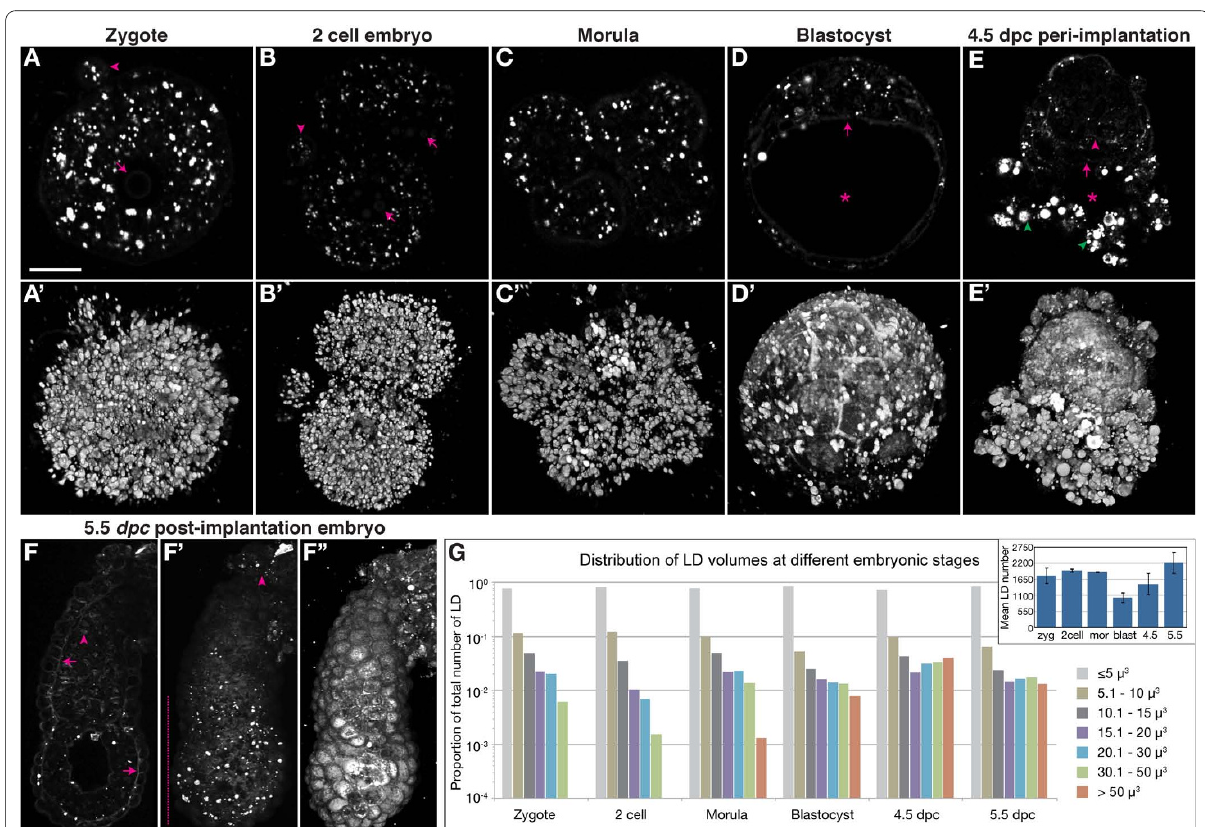
Figure 3 THG signal changes in a stage and region specific manner . (A - F) Optical sections. (A' - E' and F'') Opacity rendered 3D views. (F') Extend- ed focus maximum intensity projection. (A - C) Up to the morula stage, THG signal is predominantly from LD which are uniformly distributed through- out the embryo and polar body (arrowheads in A and B). Nucleoli also generate faint THG signal (arrows in A and B). (D) In blastocysts, LD are fewer in number and present in both the ICM (arrow) and TE. Plasma membrane starts to generate more distinct THG signal, visible more clearly in the volume rendering in D'. (E) In the implantation stage embryo, LD are mostly localised to the mural TE (green arrowheads). Plasma membrane is faintly visible and the primitive endoderm (magenta arrow) can be discerned from the epiblast (magenta arrowhead). The blastocoel cavity is marked by an asterisk in (D) and (E). (F) At post-implantation stages, LD are more abundant in the ectoplacental cone (arrowhead in F') and in the distal regions of the egg cylinder (vertical line in F'). Plasma membrane signal becomes more distinct, but is not uniform throughout the embryo, being strongest in the baso- lateral aspect of the VE (arrows). Nuclei are also now visible, but only in the ExE (arrowhead in F). (G) LD size distribution at different embryonic stages. The distribution shifts towards larger LD as the embryo develops. The inset shows mean LD number at the different stages (n = 4 for all stages except for the 2 cell stage where n = 3). Scale bar in (A) represents 20 μm for (A and C), 30 μm for (B), 32.6 μm for (D), 27.6 μm for (E) and 113.5 μm for